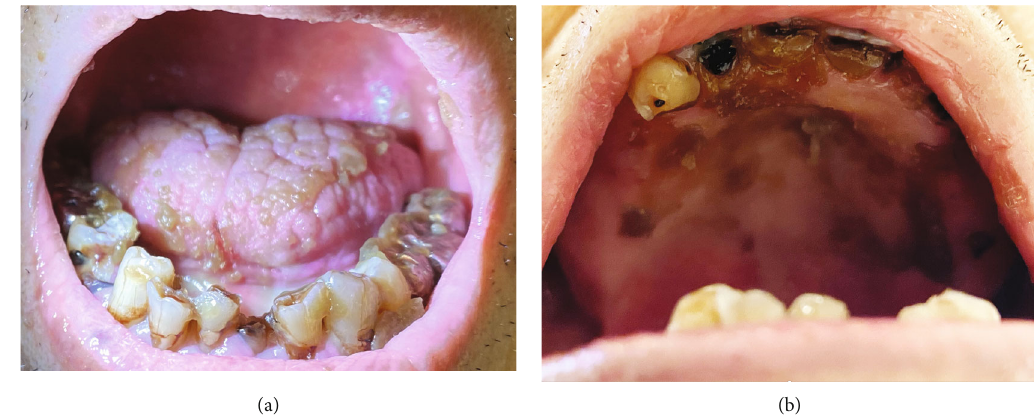
Figure 1: There was a large amount of oral desquamated epithelium. (a) Lower jaw and (b) upper